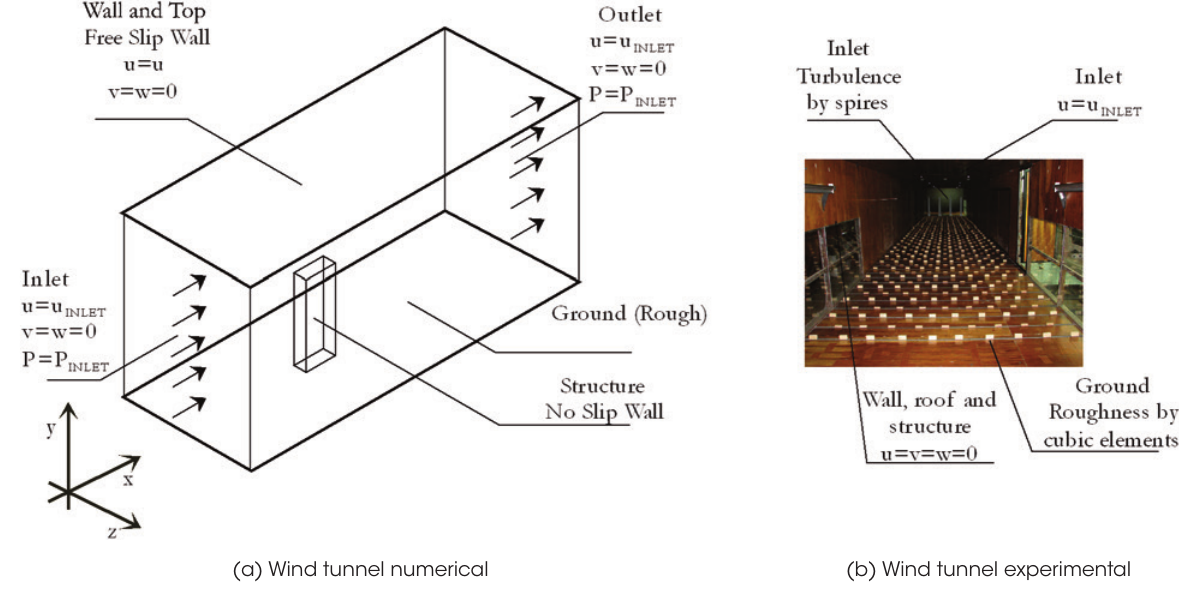
(a) Wind tunnel numerical (b) Wind tunnel